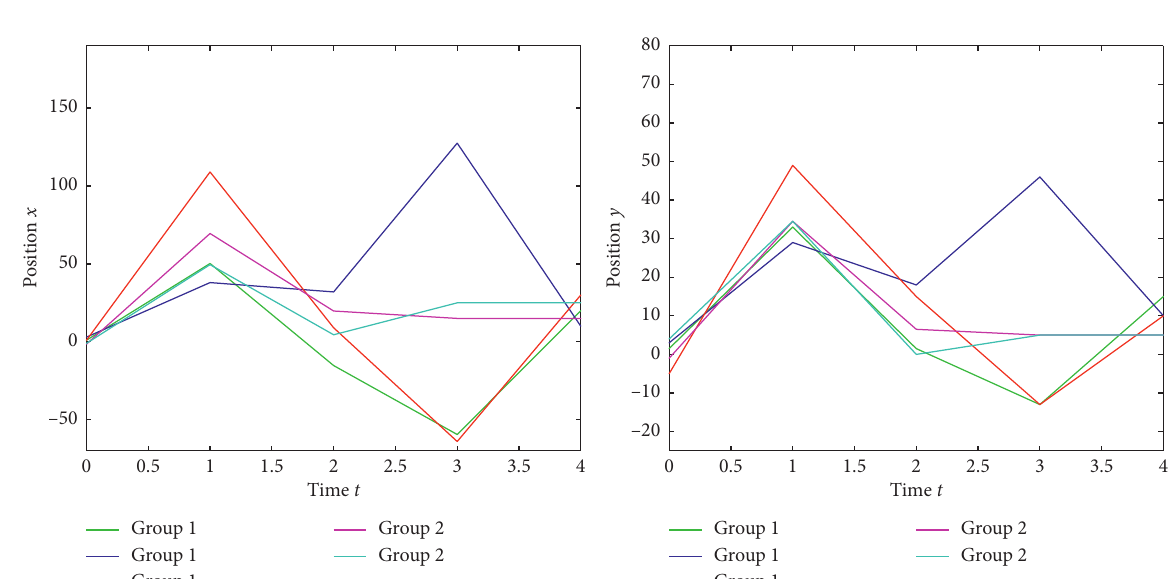
Figure 3: The time-evolution trajectories for the x − axis and y − axis corresponding to Figure